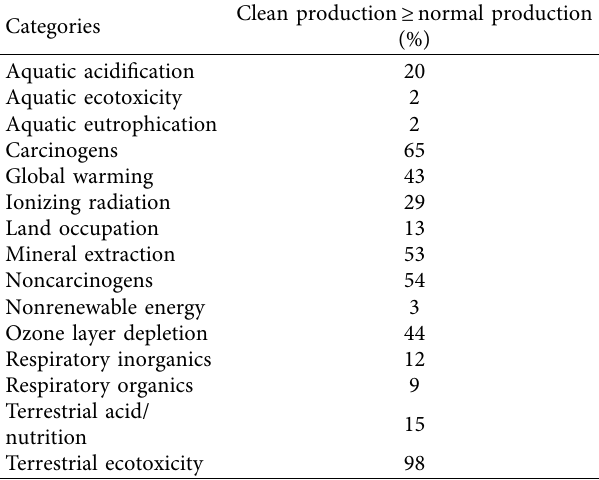
Table 5: Uncertainty